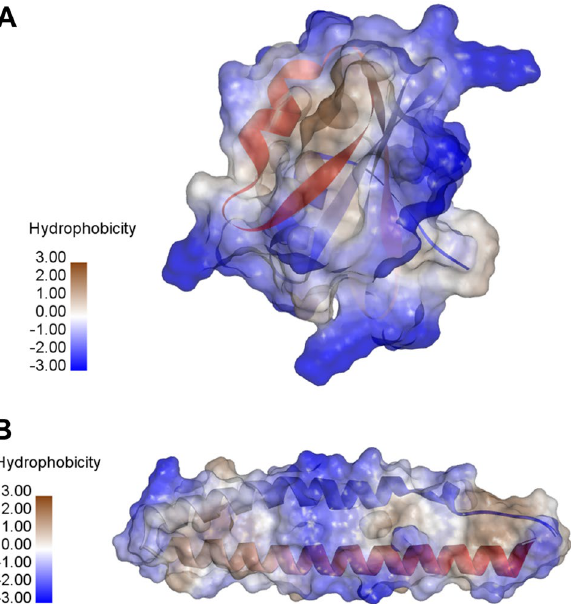
Figure 7. Surface hydrophobicity of Q9YFR9 (TPP) and P0A223 (non-TPP) having TPP scores of 528.74 and 341.99, respectively, where the optimal threshold value is 418. Brown, white and blue colors denote high, medium and low hydrophobicity,